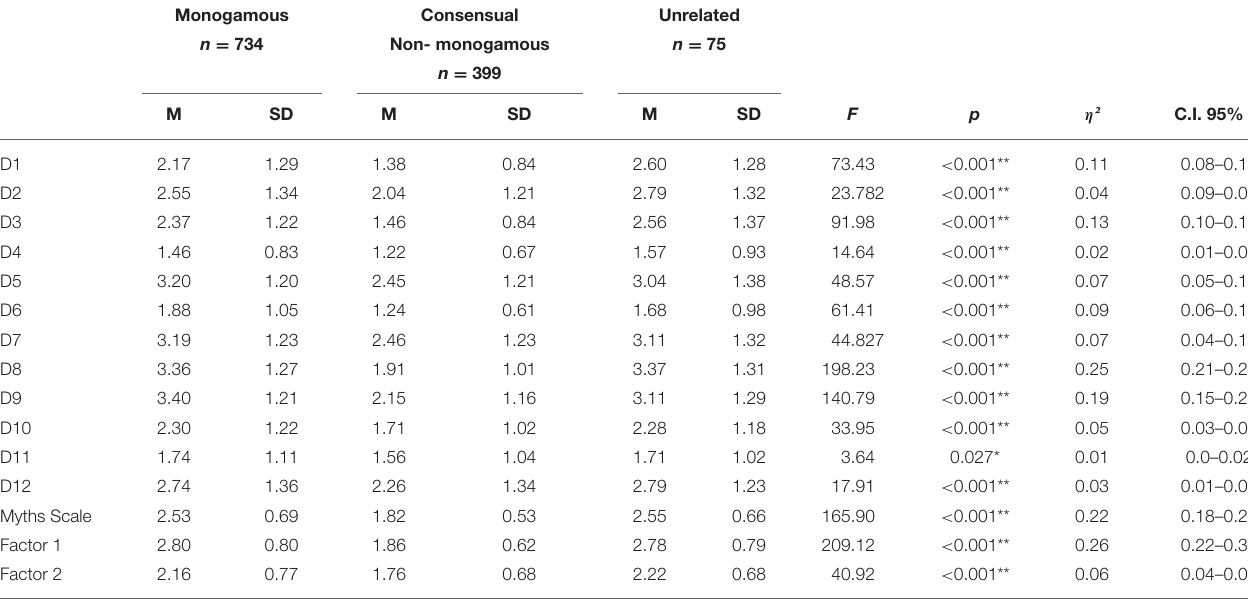
TABLE 4 | Descriptive and comparative analysis, according to type of relationship, of the Scale of Myths of Romantic Love. Monogamous